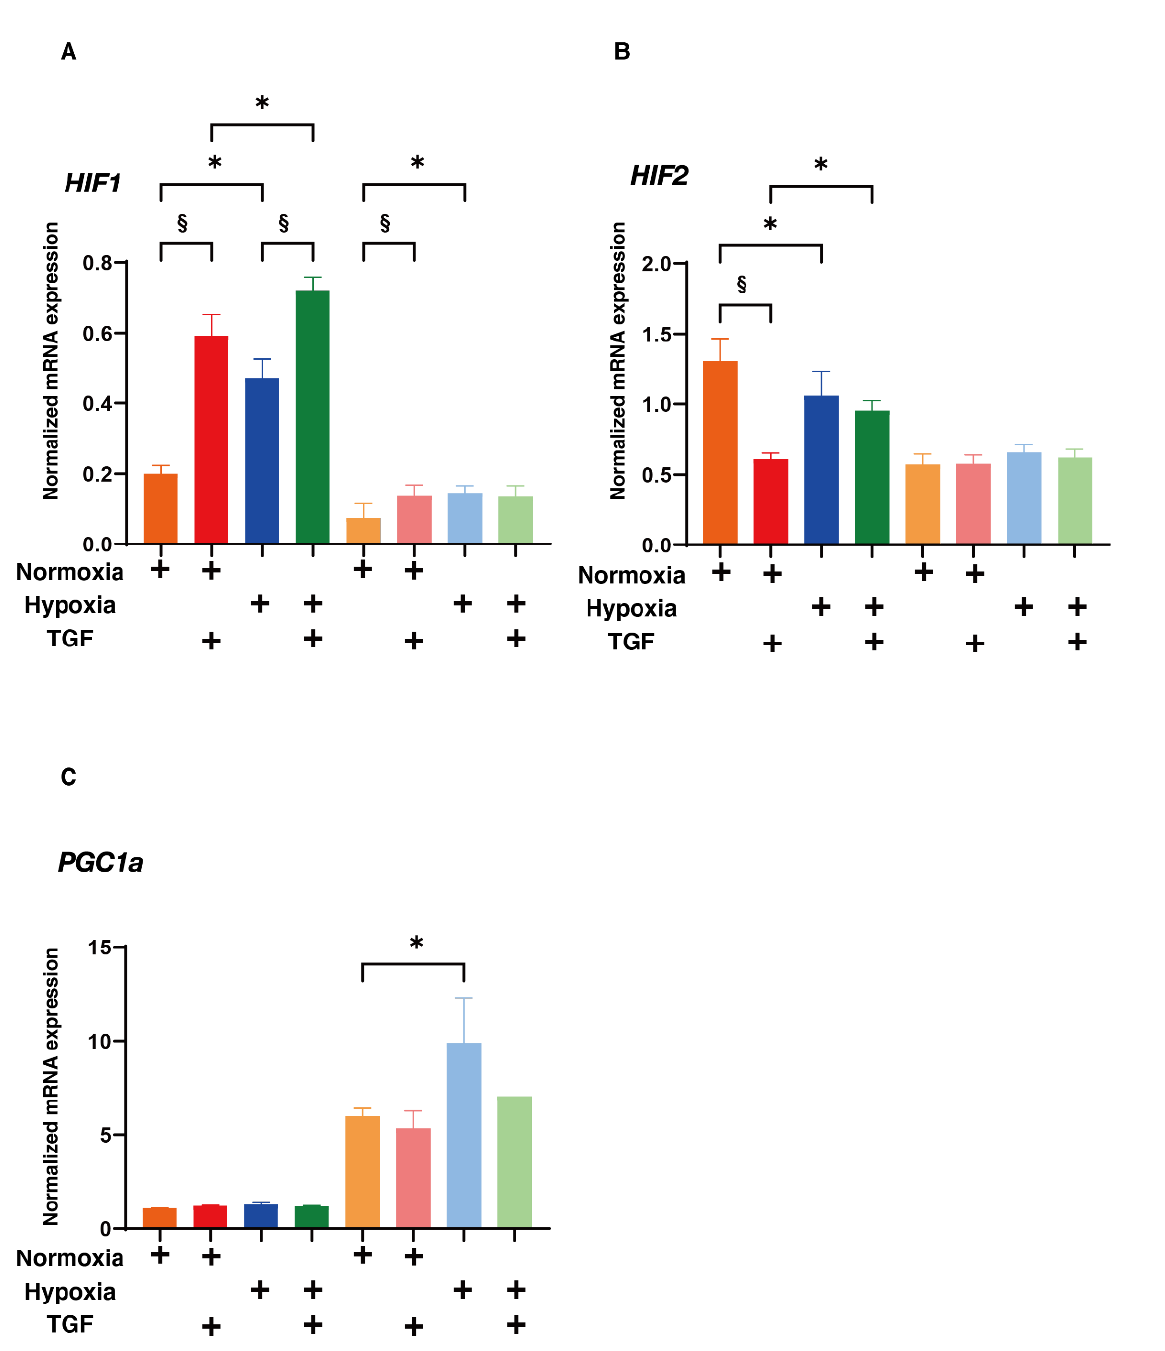
Figure 8. Effects of TGF- β 2 on the mRNA expression of hypoxia-related factors; ( A , B ) HIF1 α and 2 α and mitochondria regulatory gene; ( C ) PGC1a of 2D and 3D HRPE cells under normoxia or hypoxia conditions. Two-dimensional and three-dimensional cultured HRPE cells at Day 6 prepared under normoxia and hypoxia conditions were treated without (control) or with a 5 ng/mL solution of TGF- β 2 (TGF β ), and each sample was subjected to qPCR analysis and the expression of mRNA in hypoxia-related factors; HIF1 α and 2 α and mitochondria regulatory gene; PGC1a were estimated. All experiments were performed in duplicate using fresh preparations (2D; n = 5, 3D; n = 10 spheroids each). “+” is reagents addition. Data are presented as the arithmetic mean ± the standard error of the mean (SEM). * p < 0.05 control vs. TGF, § p < 0.05 normoxia vs. hypoxia (ANOVA followed by a Tukey’s multiple comparison